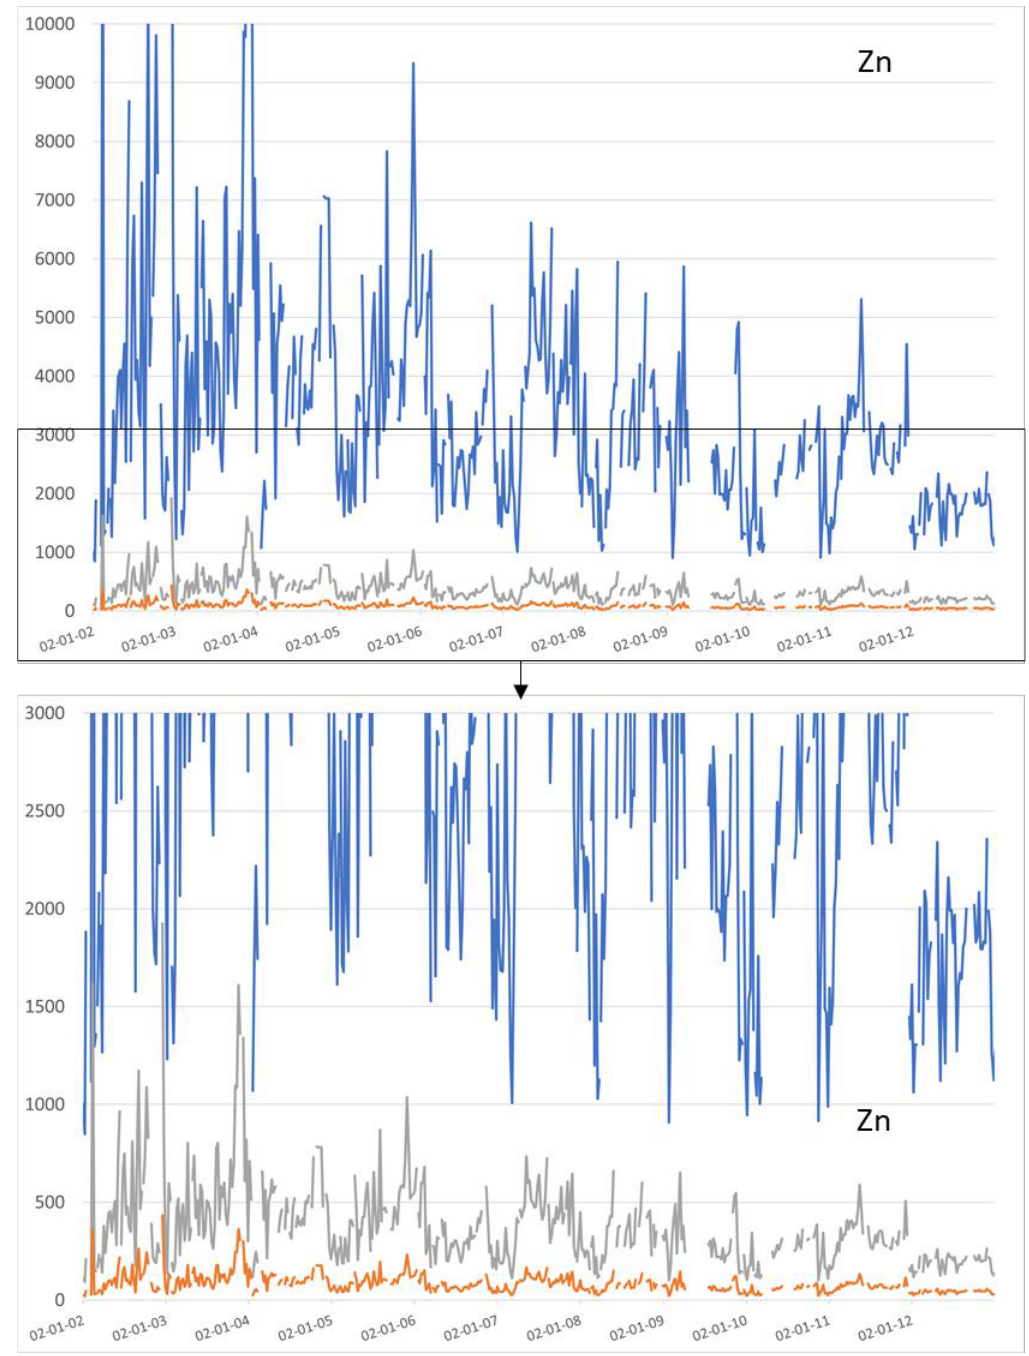
Figure 5. Zinc mass concentrations (mg/kg) at Eijsden (Meuse river) of the suspended sediment: clays = particles < 2 µm (average diameter = 1 µm), fine silts = 2 µm < particles < 16 µm (average diameter = 9 µm) and coarse silts = 16 µm < particles < 63 µm (average diameter = 40 µm). The top figure ’s y-axis scale from 0 to 10,000 mg/kg; the bottom figure ’s y-axis scale from 0 to 3000 mg/kg.